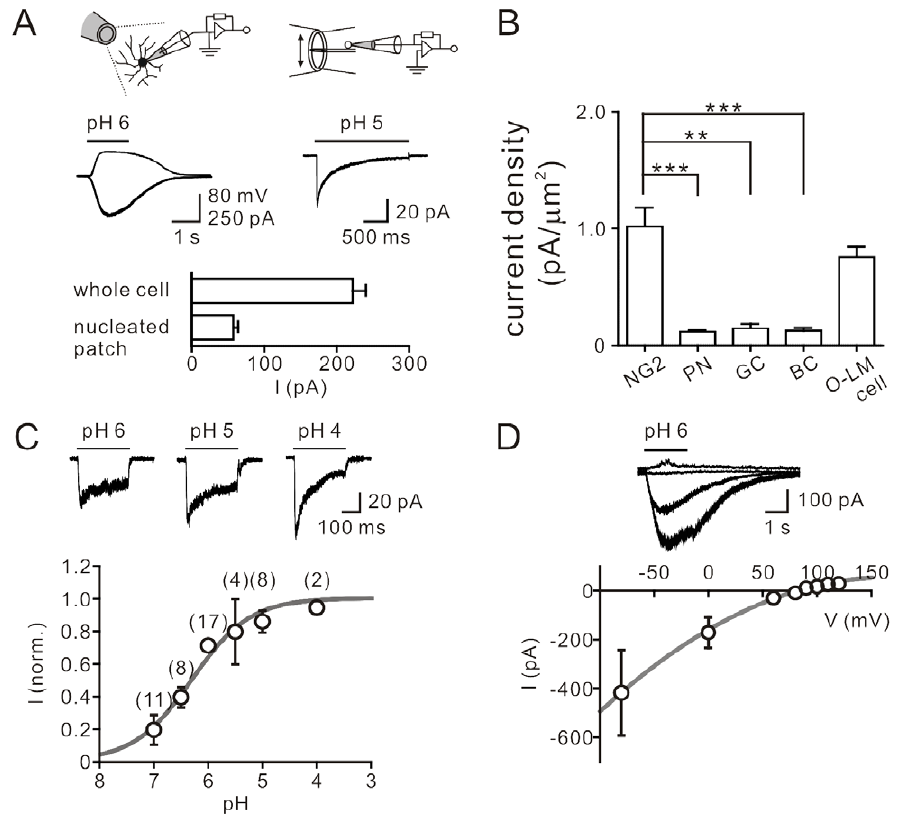
Figure 3. ASIC currents are present in NG2 cells. (A) Top, schematics of whole-cell (left) and nucleated patch (right) recordings. Middle left, puffer application of acid onto an NG2 cell elicited inward currents ( V -clamp at 2 80 mV) or membrane depolarization ( I -clamp, V m = 2 80 mV before the pulse). Middle right, ASIC currents evoked by fast application technique in a nucleated patch from an NG2 cell ( V -clamp at 2 60 mV). Bottom, summary of acid-evoked ASIC currents. (B) ASIC current density in NG2 cells compared to various types of neurons in the CA1 area and dentate gyrus. PN, pyramidal neuron; GC, granule cell; BC, basket cell; O-LM cell, oriens lacunosum-moleculare cell. ** P , 0.005; *** P , 0.0005. (C) Top, ASIC currents evoked by different pH reductions. Bottom, the normalized peak amplitude of ASIC current plotted against the pH value. Data fit with the Hill equation. (D) Top, overlay of ASIC currents recorded at different potentials ( 2 80, 0, + 80 and + 100 mV). Bottom, the I-V relationship had the reversal potential of + 85 mV. Data (pooled from 8 cells) fit with a polynomial